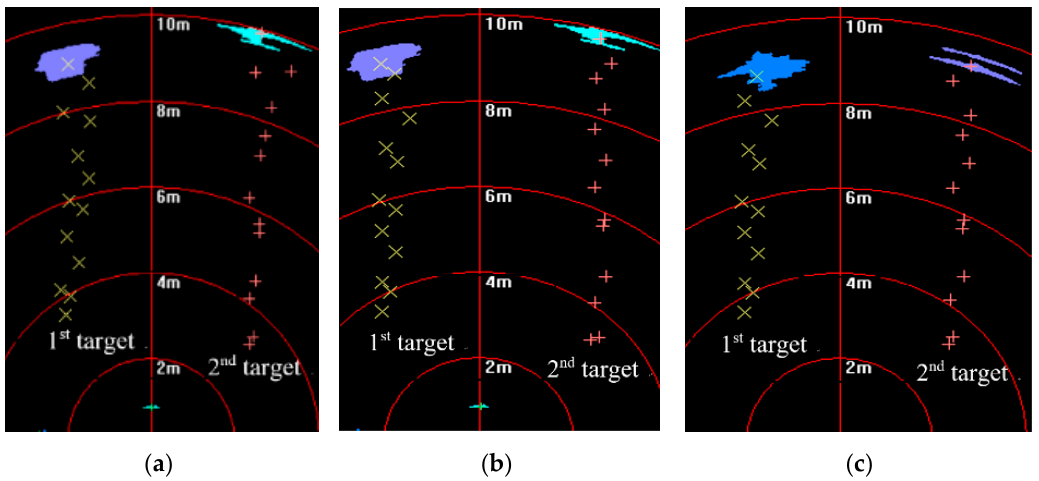
Figure 14. Tracking results based on different fusion strategies gained by: ( a ) multiplicative fusion (MF); ( b ) weighted fusion (WF), and ( c ) proposed method.